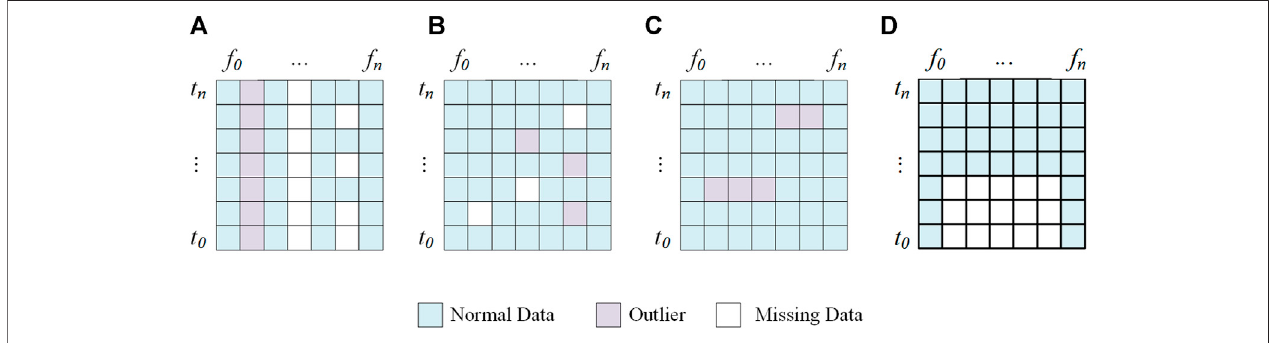
FIGURE 1 | The distribution of abnormal voltage data for several reasons: (A) Abnormal voltage data cause by Metering equipment; (B) Abnormal voltage data cause by faults; (C) Abnormal voltage data cause by operation control; (D) Abnormal voltage data caused by the communication system.